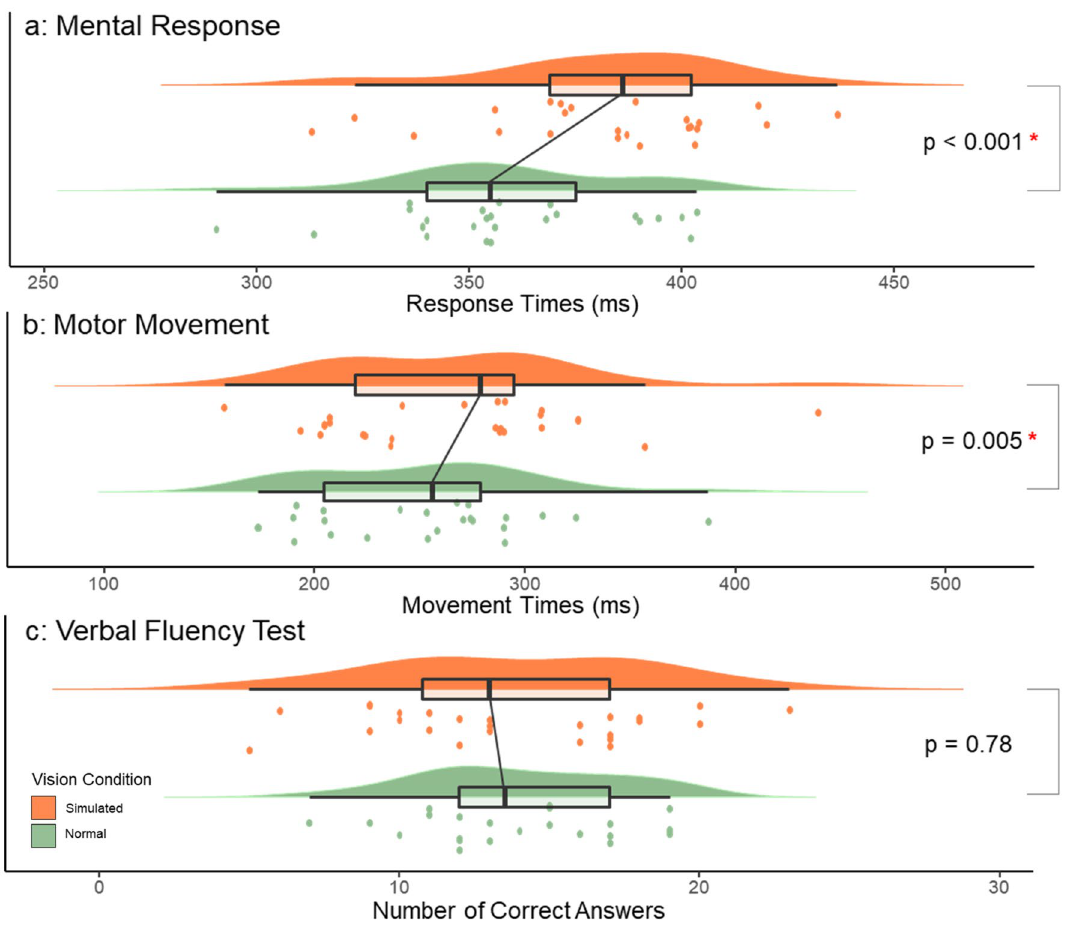
Figure 3. Normal and simulated AMD vision results. ( a ) RTI mental responses. Main effect of vision ( p < 0.001). ( b ) RTI motor movements. Main effect of vision ( p = 0.005). Interaction between vision and order ( p = 0.01). ( c ) VFT correct answers. Main effect of vision ( p = 0.78). Significance level: p <